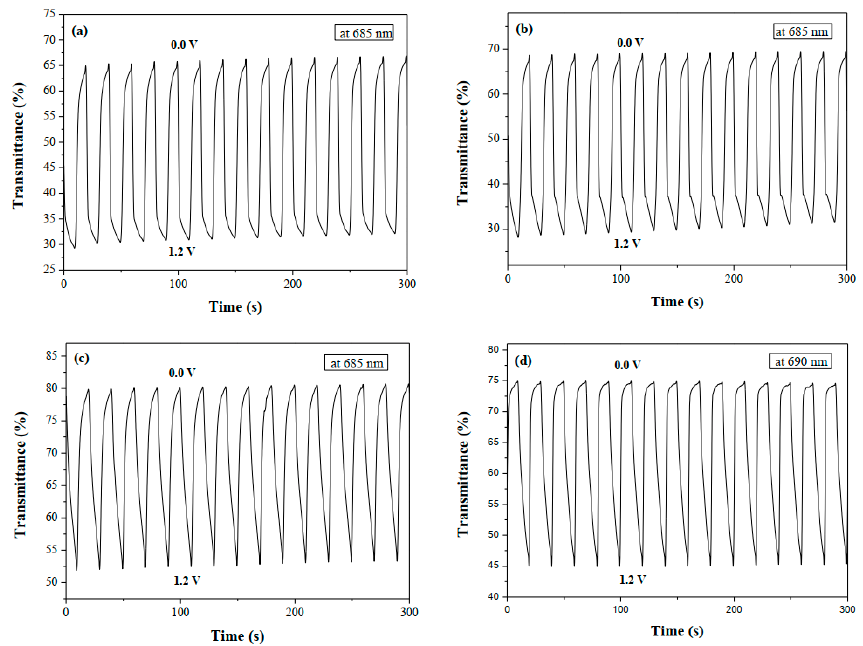
Figure 7. Optical contrast of ( a ) PbCmB, ( b ) P(bCmB- co -bTP), ( c ) P(bCmB- co -dbBT), and ( d ) P(bCmB-